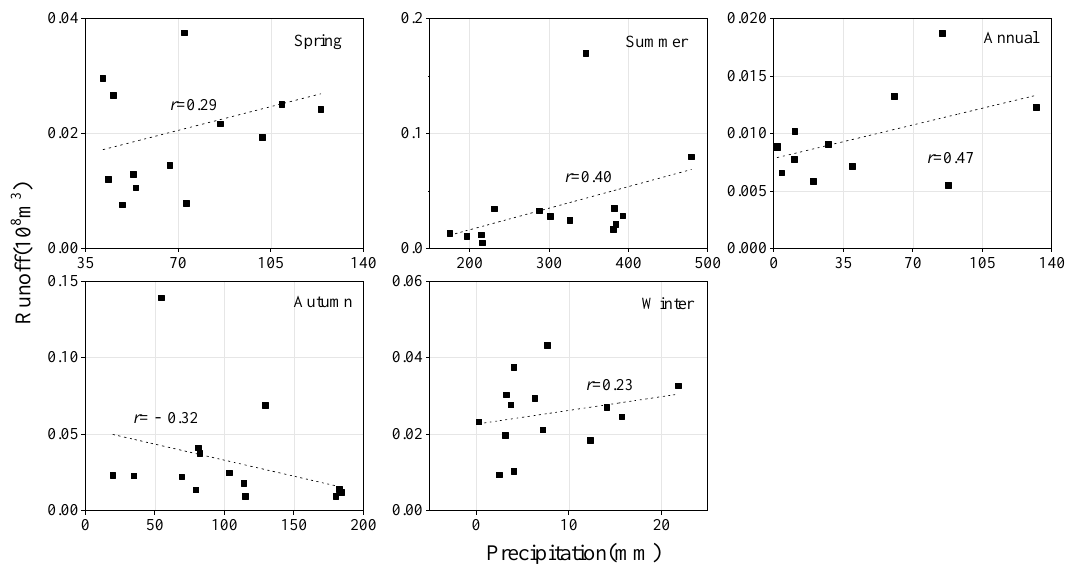
Figure 10. Correlation between runoff and precipitation at annual and seasonal scales.